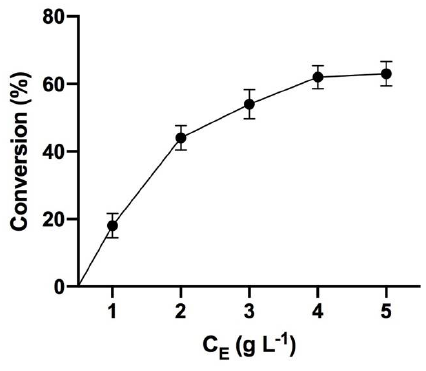
Figure 2. Effect of enzyme concentration at 720 RPM conversion yield of sorbic acid. Figure 2. E ff ect of enzyme concentration at 720 RPM conversion yield of sorbic